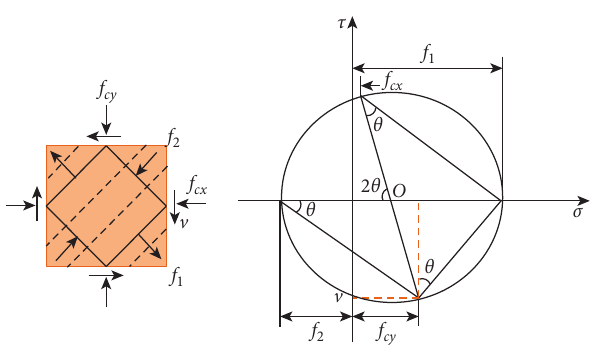
Figure 2: Mohr’s circle for average stresses.